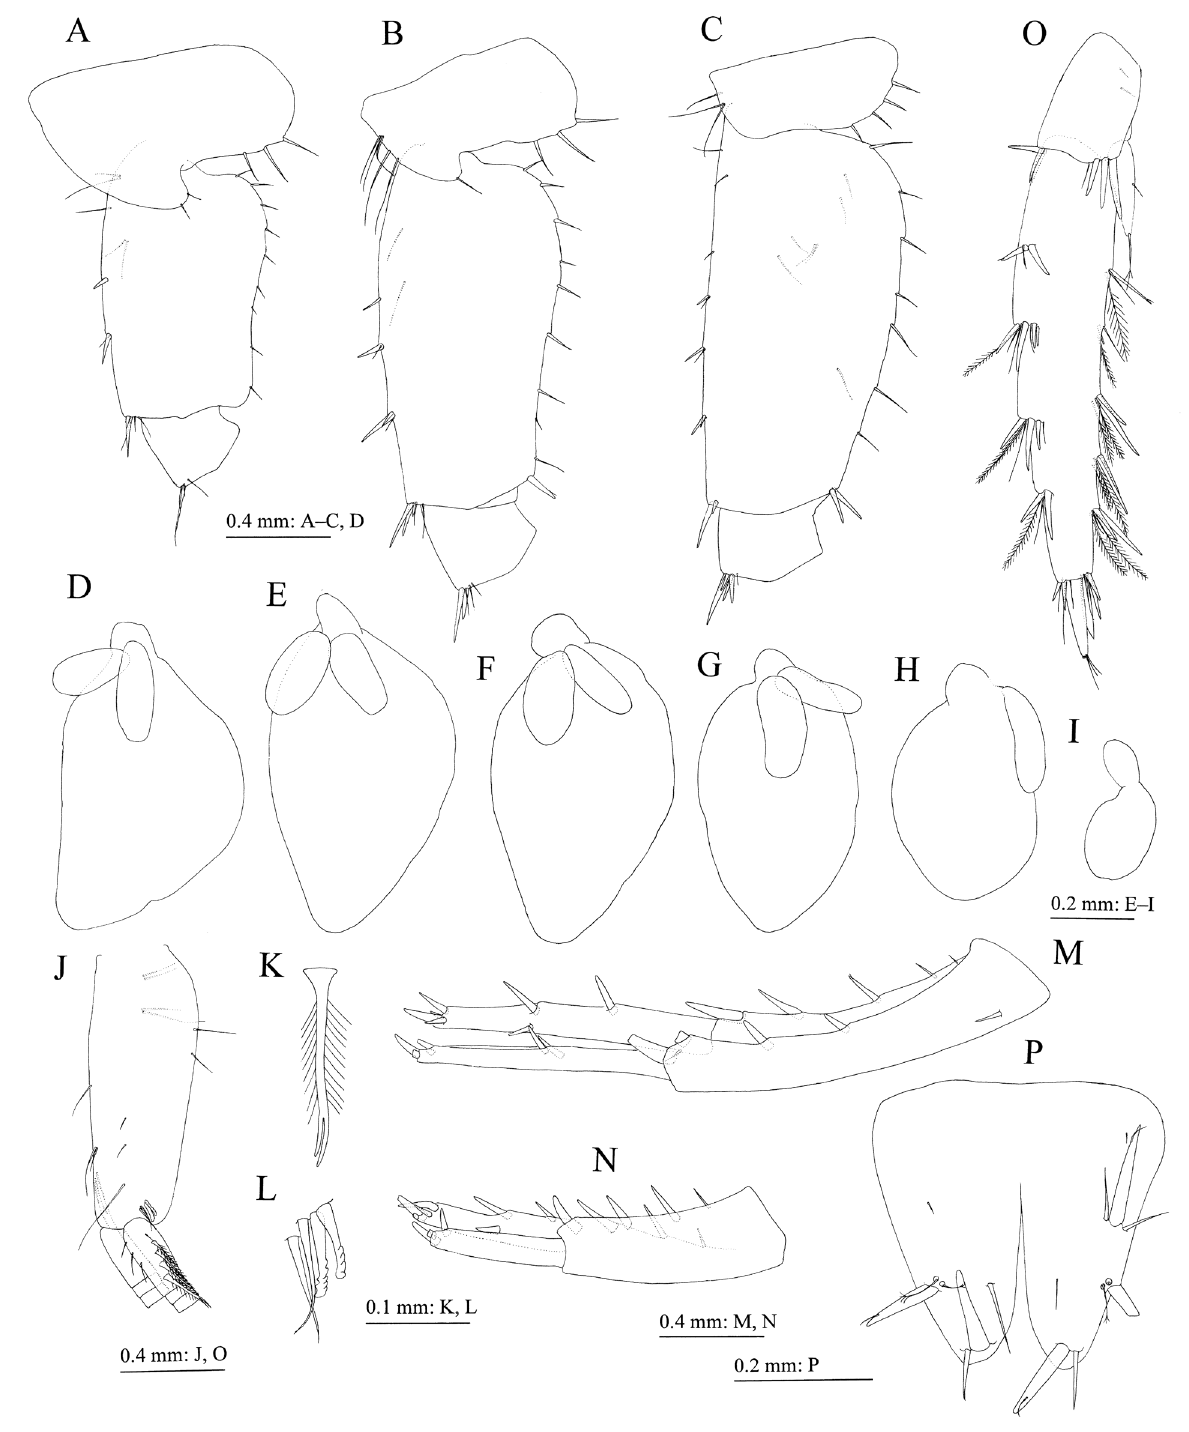
Figure 12. Jesogammarus uchiyamaryui sp. n., holotype, male (10.3 mm), NSMT-Cr 25474. A coxa–ischium of pereopod 5, lateral view; B coxa–ischium of pereopod 6, lateral view; C coxa–ischium of pereopod 7, lateral view; D–I coxal gills on gnathopod 2 and pereopods 3–7, lateral views; J pleopod 1, lateral view, distal parts of rami omitted; K bifid plumose seta (clothes-pin seta) on inner basal margin of inner ramus of pleopod 1, lateral view; L retinacula on peduncle of pleopod 1, lateral view; M uropod 1, dorsal view; N uropod 2, dorsal view; O uropod 3, dorsal view; P telson, dorsal